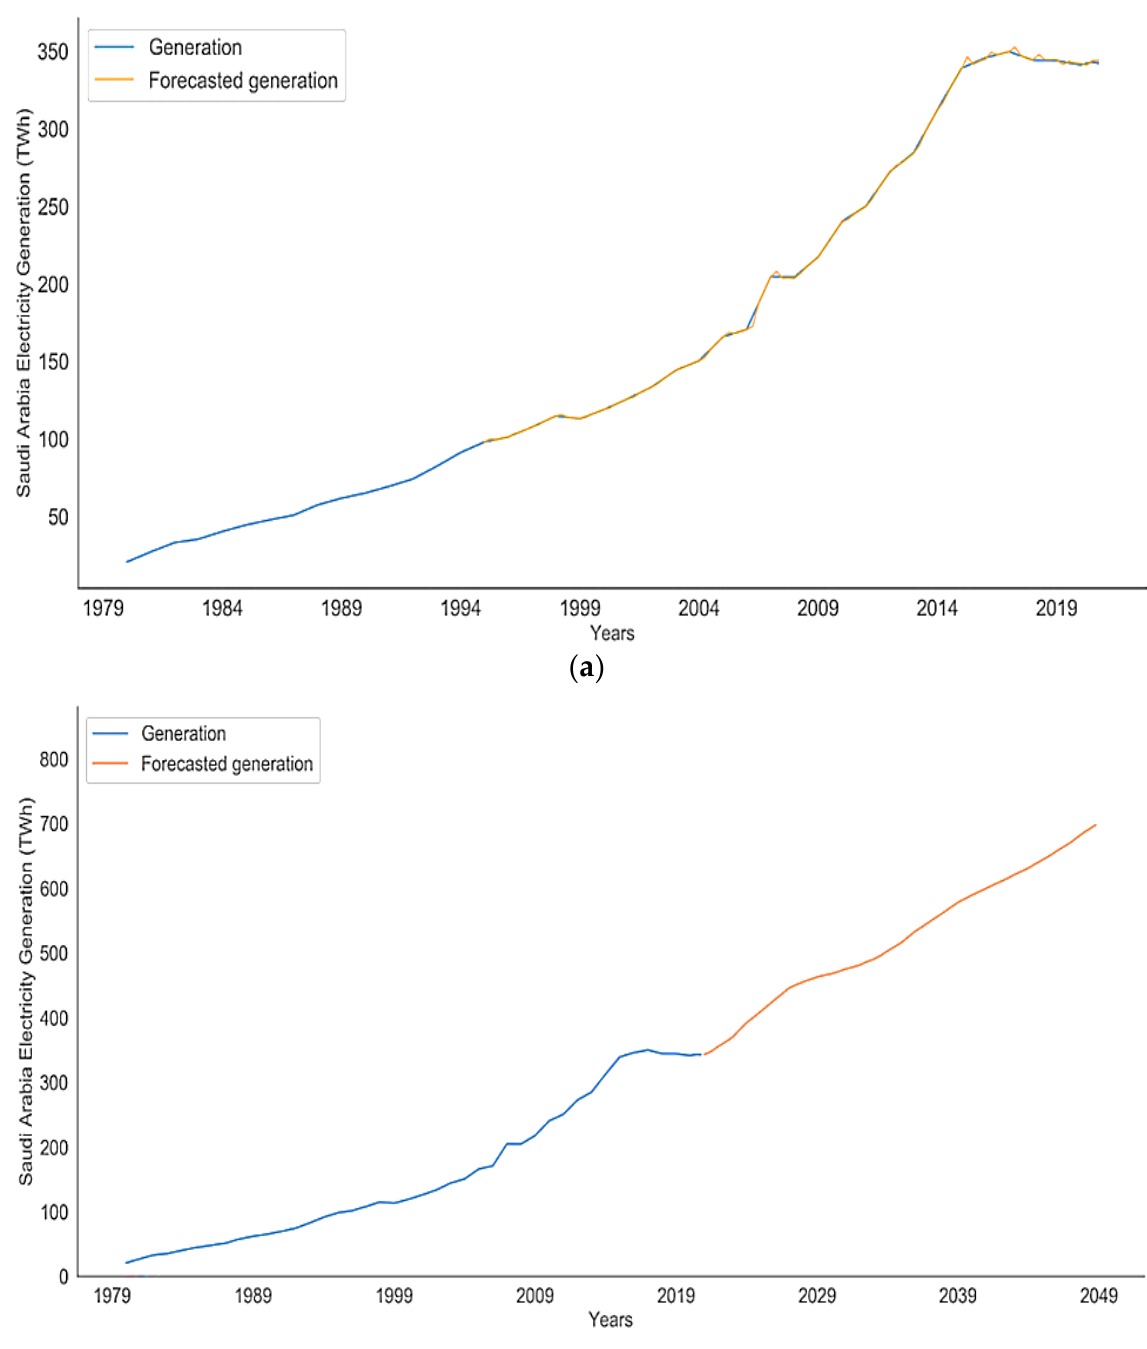
Figure 6. ( a ) Real and forecasted values of electricity generation, which show the good fit and performance of the SARIMAX model. ( b ) Forecasted electricity generation values for the 30-year period from 2021 to 2050.